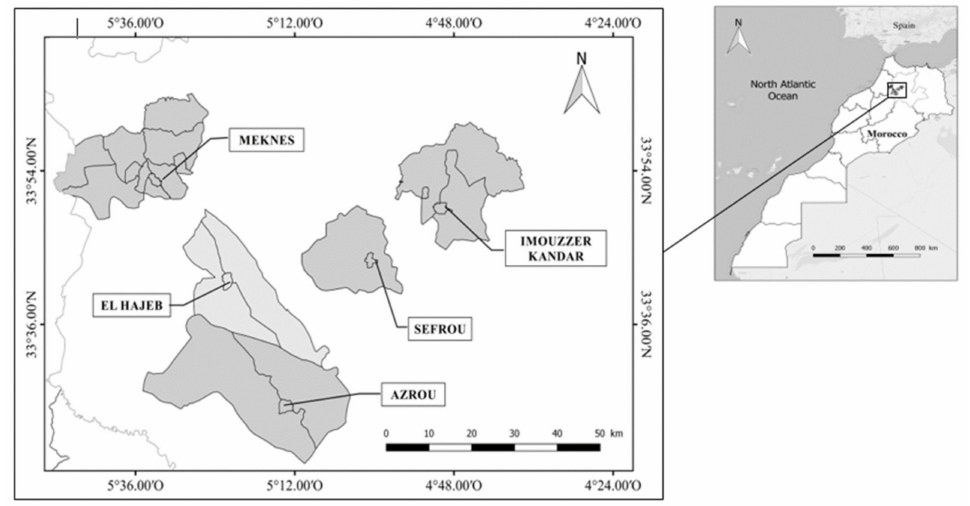
Figure 1. Map showing locations of the Meknes-Fes region in Morocco (Upper quadrat) and enlarged views of Meknes, El-Hajeb, Imouzzer-Kander, Sefrou, and Azrou (from the shaded square). The map was performed by ArcGIS software (v.10.9) and indicated the names of different districts where samples were